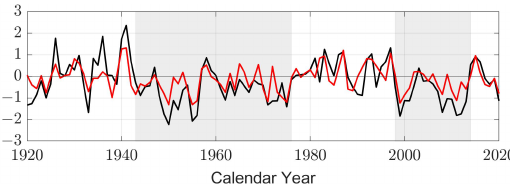
Figure 2. Pacific decadal oscillation (PDO) index ( —— ) [34] and Tripole index (TPI) ( —— ) of inter- decadal Pacific oscillation (IPO) [36] in 1920–2020.